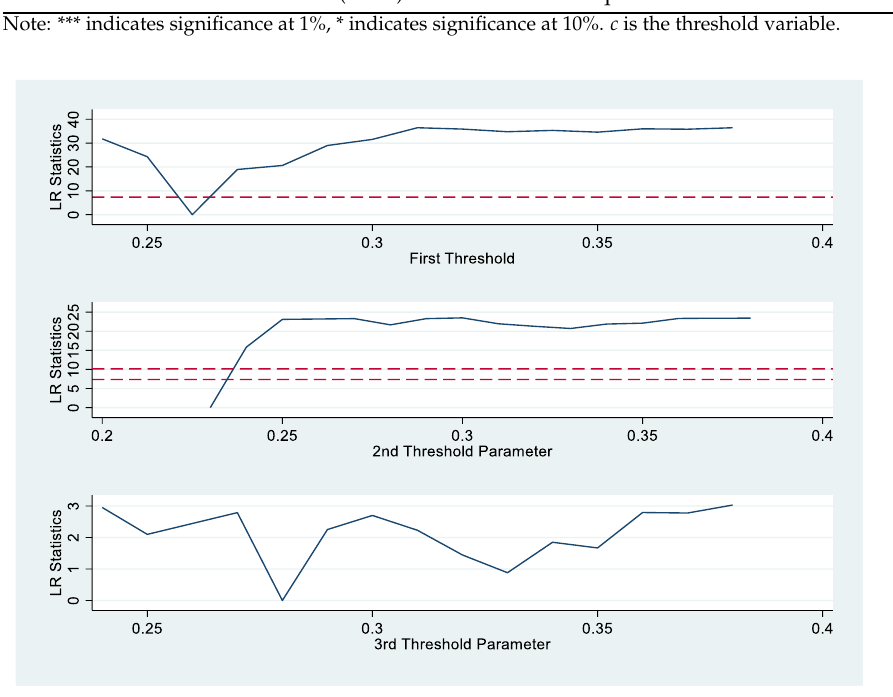
Figure 1. Threshold results of HC. Note: solid blue line indicates LR. Red dotted line indicates the 95% value.